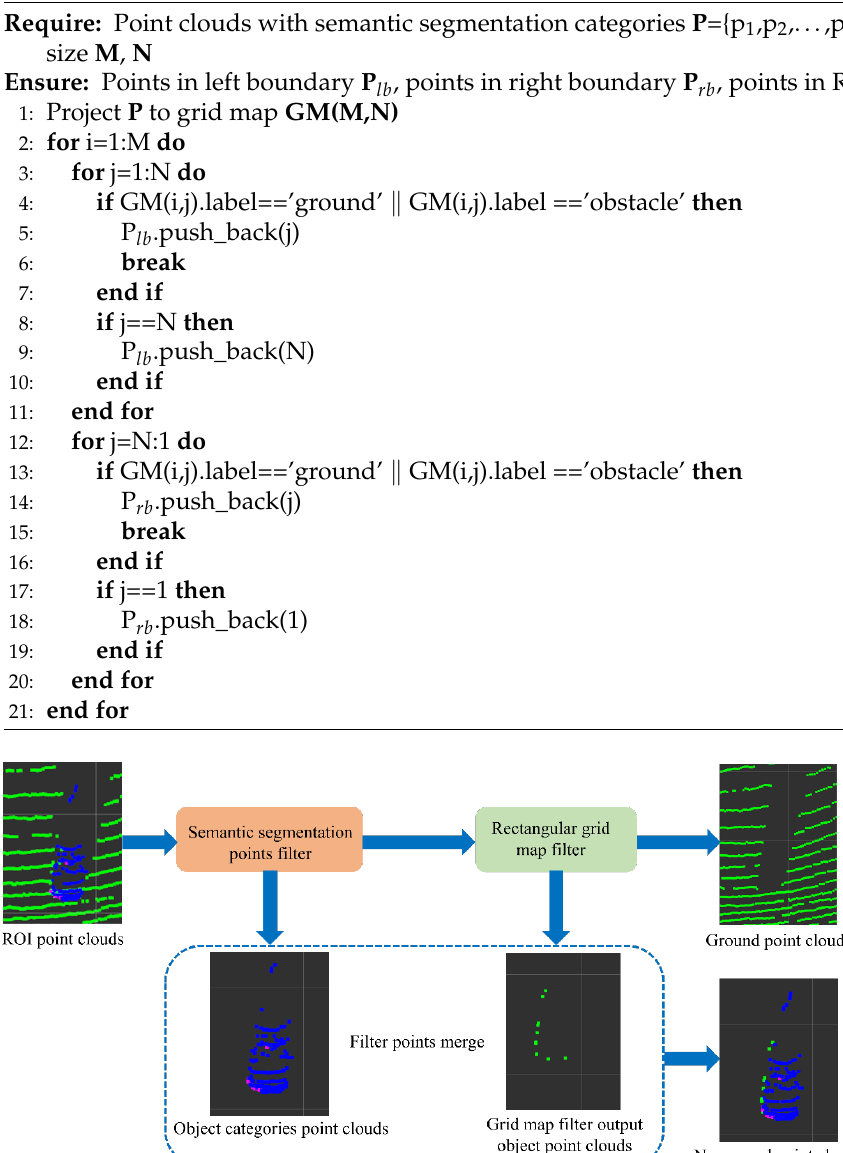
Algorithm 1 Road region searching.